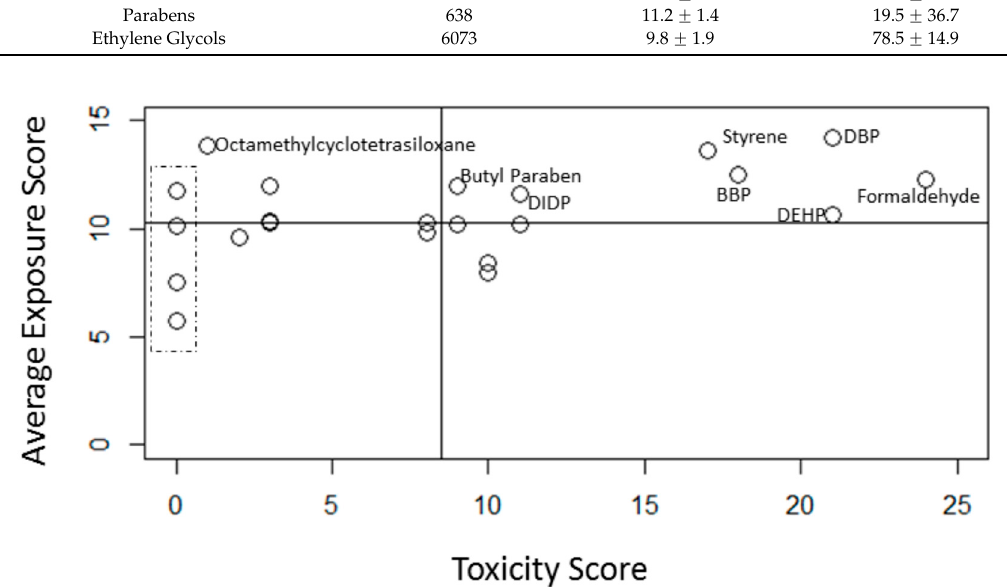
Figure 1 Figure 1. Scatterplot showing the relationship between toxicity and average exposure scores for chemicals in the CSPA framework. The scatterplot is divided into quadrants with lines drawn at the median exposure score (horizontal line) and median toxicity score (vertical line) to emphasize that chemicals relatively high for both toxicity an exposure scores (upper right-hand quadrant) are of higher concern than those with relatively lower scores for both toxicity and potency (lower left-hand quadrant). Formaldehyde, styrene, benzyl butyl phthalate (BBP), DBP and DEHP all fall in the highest priority quadrant in this figure. Other phthalates, diisodecyl phthalate (DIDP) and di-n-hexyl phthalate (DnHP) also fall in the high priority quadrant. The dashed box on the far left indicates chemicals such as phthalic anhydride, propyl paraben, molybdenum and methyl paraben which were not identified as known toxicants (NT, RD, ED or carcinogens) in any of the databases